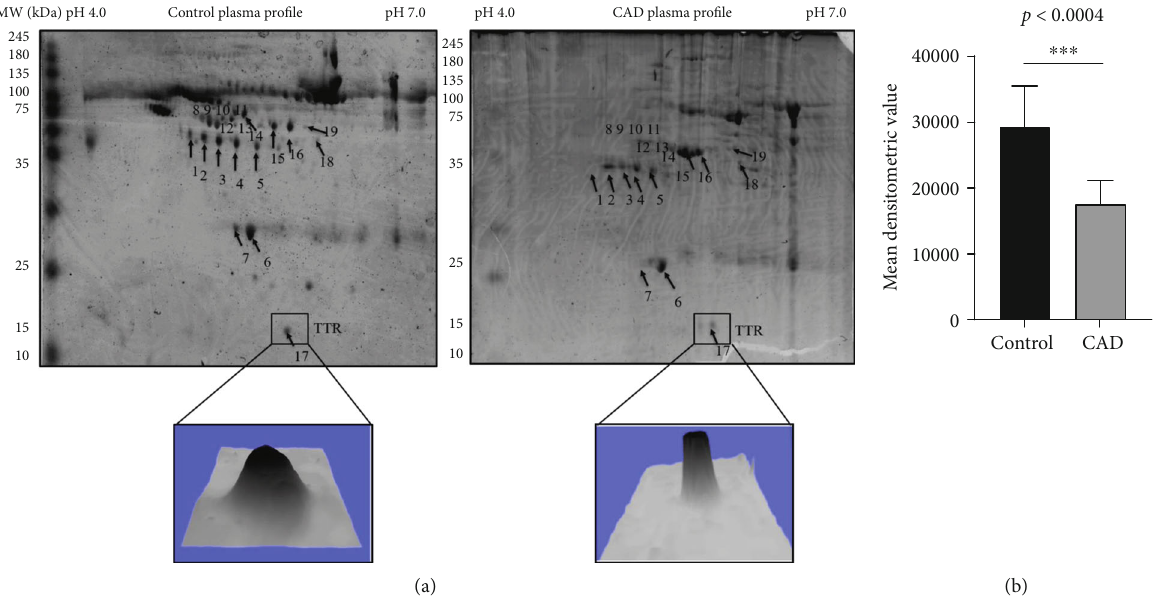
Figure 1: Two-dimensional gel electrophoresis of plasma proteins. (a) Representative 2-DE gel image of plasma proteins and 3D view distinctly indicates the spot intensity of TTR CAD plasma, compared to the healthy control. (b) TTR densitometry analysis indicated low level in CAD with signi fi cant di ff erence 1.7-fold p < 0 : 0004 in comparison to control. The protein spot normalized to the total spot intensity in the gel. The threshold level for the di ff erential protein level was considered as at least 1.5-fold increase or decrease in spot intensity that was signi fi cant at the p < 0 : 05 level using Student ’ s t -test. TTR: transthyretin; CAD: coronary artery